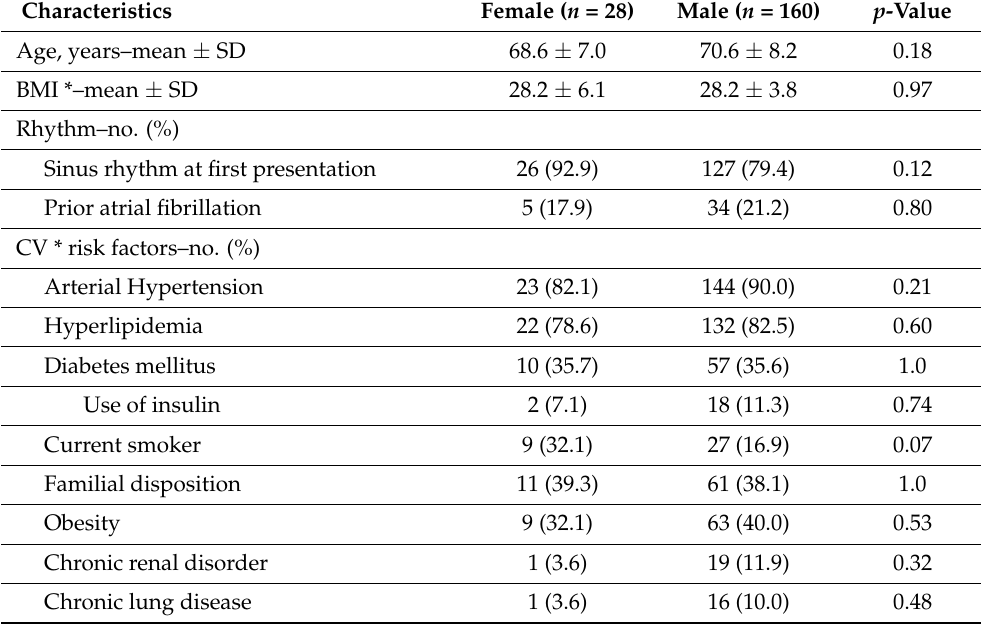
Table 1. Baseline characteristics of the study population categorized by gender. Continuous data are presented as mean ± standard deviation. The body mass index is the weight in kilograms divided by the square of the height in meters. The EuroSCORE indicates the percent risk of death within 30 days after surgery. The score is calculated with multivariable models that incorporate clinical predictors to estimate the operative mortality for any given